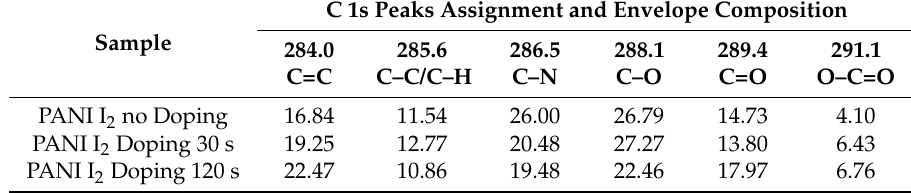
Table 2. Peak assignment (BE, eV) and envelope composition (%, total = 100) of various N 1s core level spectra of PANI observed in XPS spectra in Figure